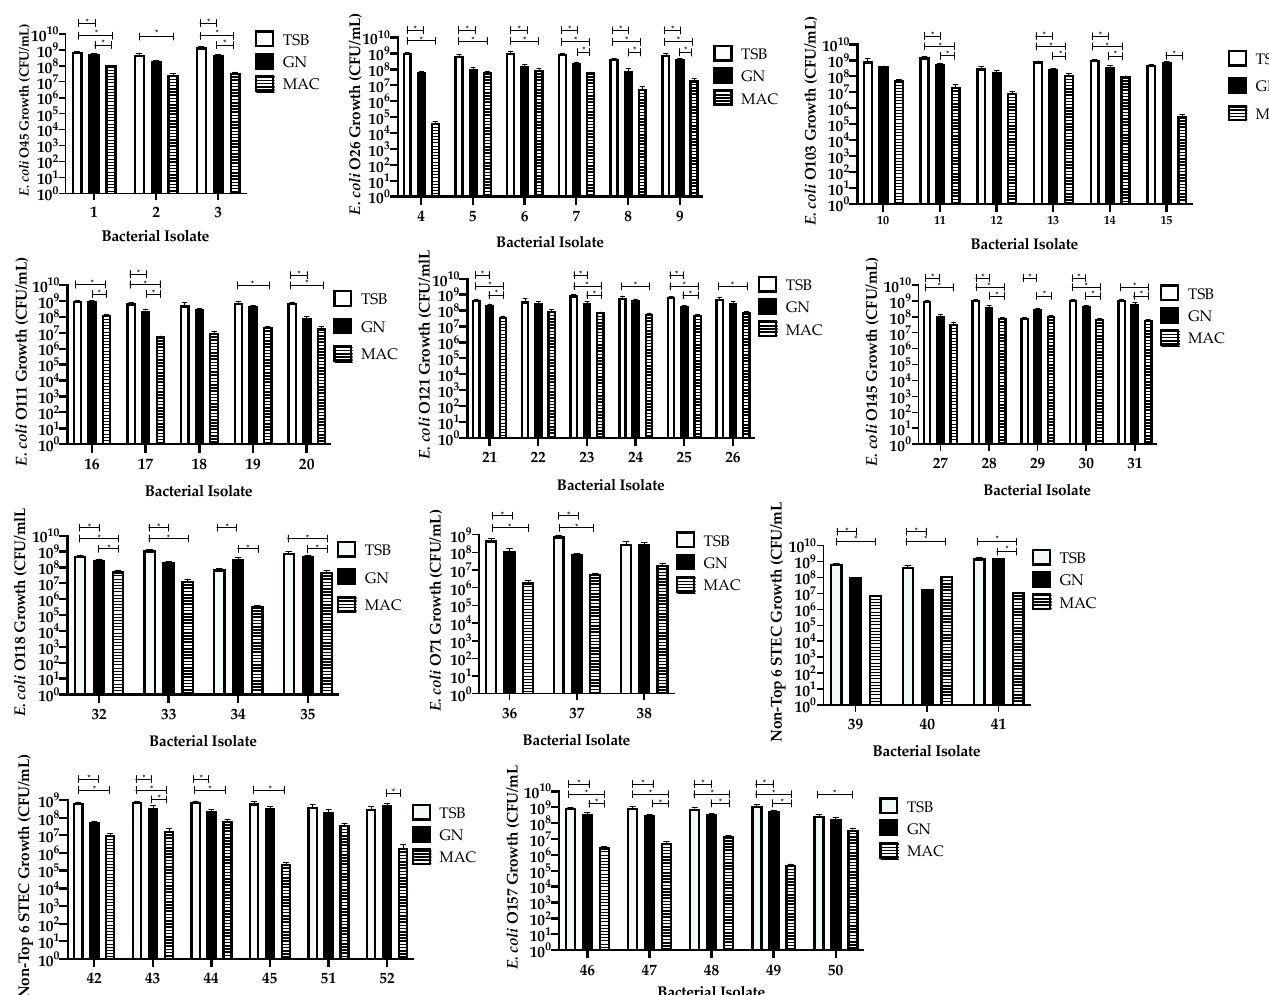
Figure 2. Effects of different enrichments broths tryptic soy broth (TSB), GN, and MacConkey (MAC) on the growth of STEC isolates ( n = 52 isolates). Bars represent the CFU/mL calculated from serial dilutions plated in triplicate on BAP. Error bars represent the standard error of the mean. * Growth is significant; ANOVA p ≤ 0.05. Table 2. Percentage of isolates with significantly different growth in each broth ( n = 52). Broth TSB GN Mac TSB NA 38 (71%) 42 (81%) GN 2 (3%) NA 28 (54%) Mac